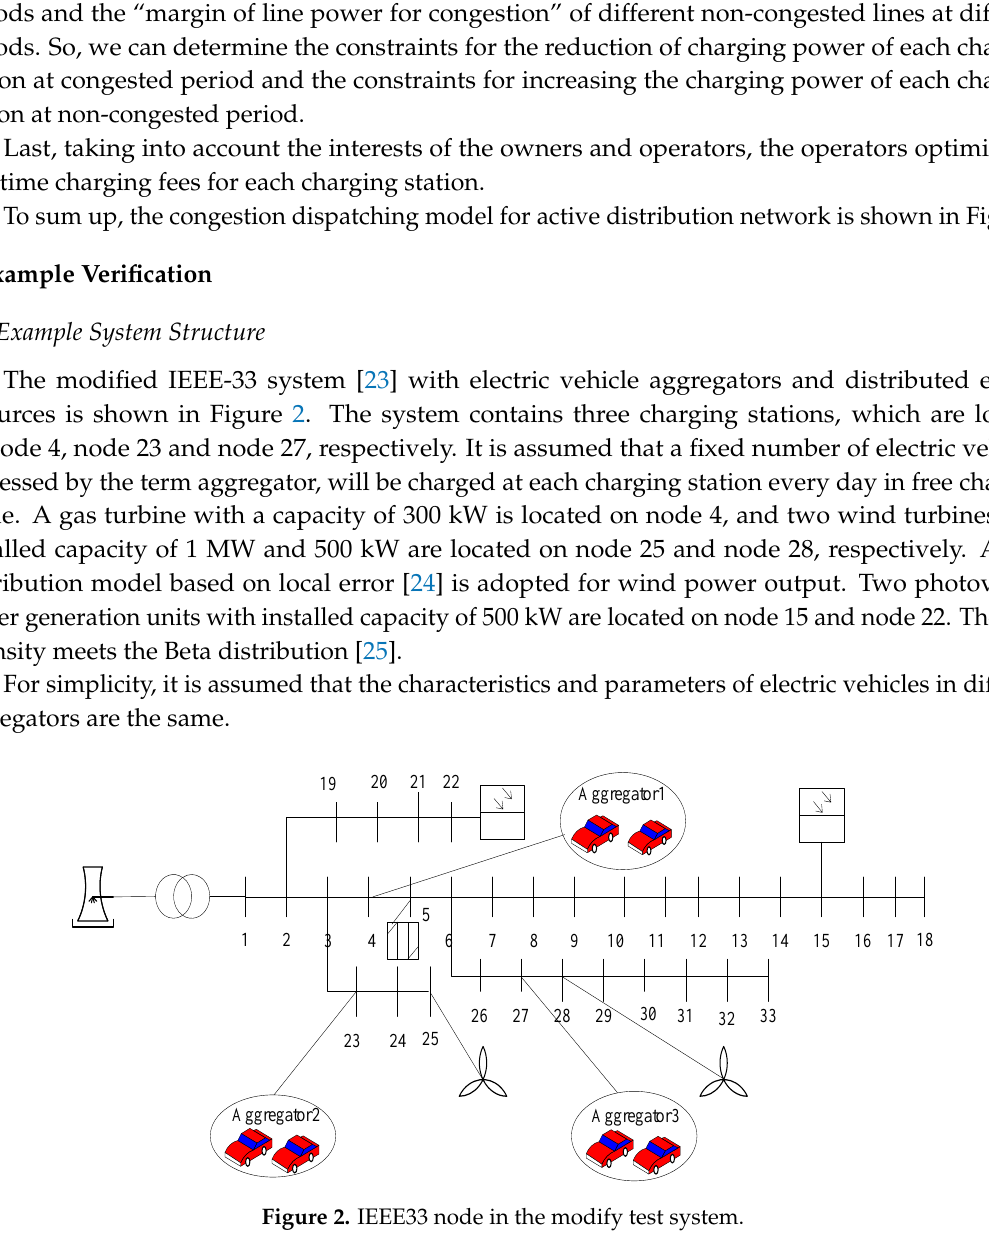
Figure 3. Charging power distribution of each aggregator in EV free charging mode. 4.3. Adjustment Mode for Charging Fees After implementing the real-time charging fees policy, the distribution of charging power of each aggregator is shown in Figure 4. The charging power of each charging station at each period before and after the adjustment for charging fees is shown in Tables A1 and A2 in Appendix A.